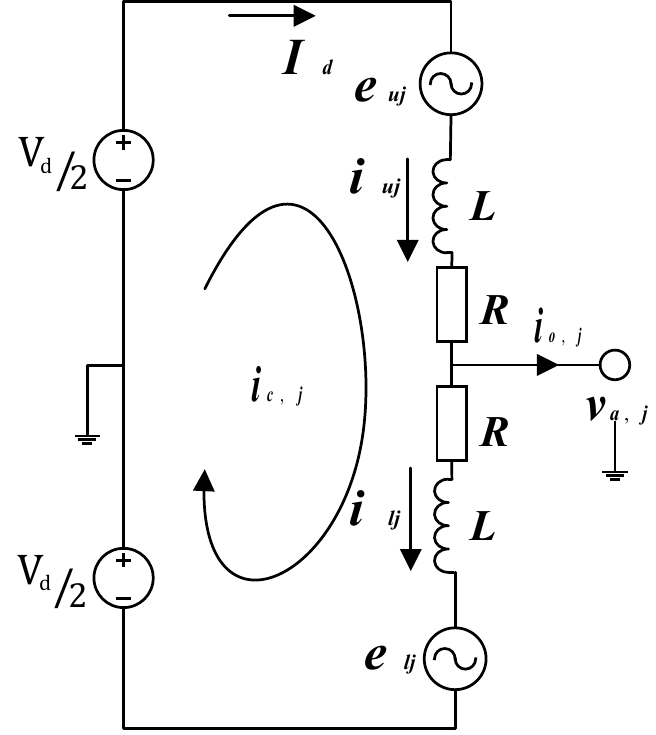
Figure 2. Equivalent circuit of MMC.